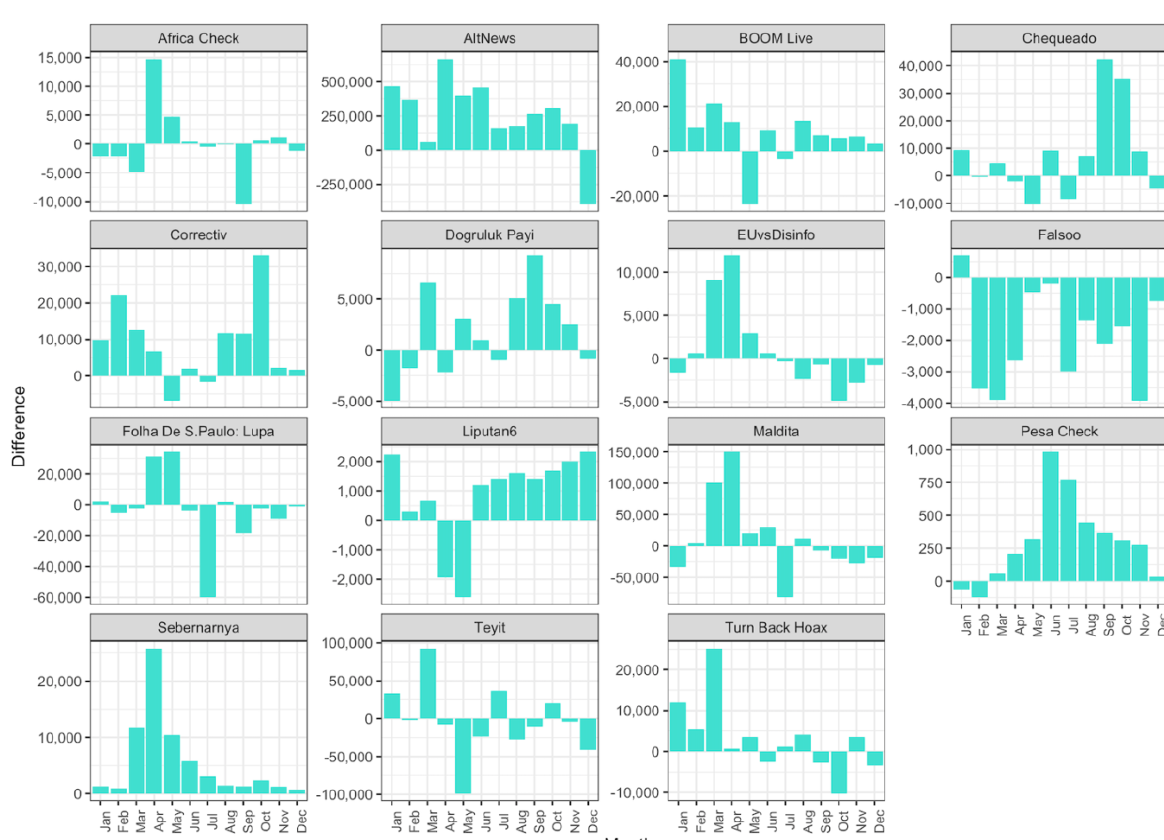
Figure B1. Difference in total engagement by users. The difference in total engagement by users was calculated by subtracting total engagement by users in 2019 from the total engagement by users in